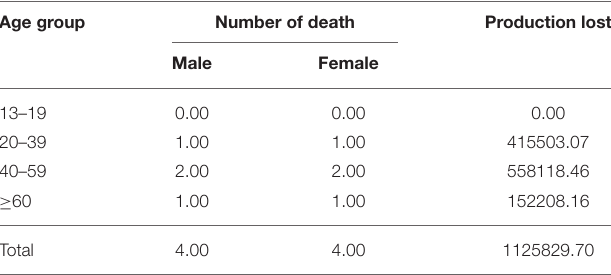
TABLE 4 | Production lost due to premature death from poisoning with mushrooms in Kermanshah province,